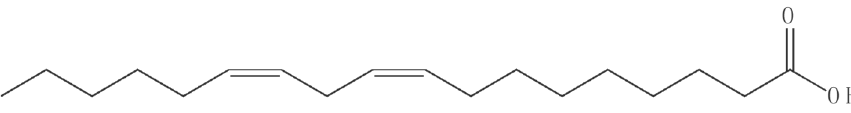
Figure 3. Structure of bioactive compound isolated from Holigarna (H.) caustica (linoleic acid).